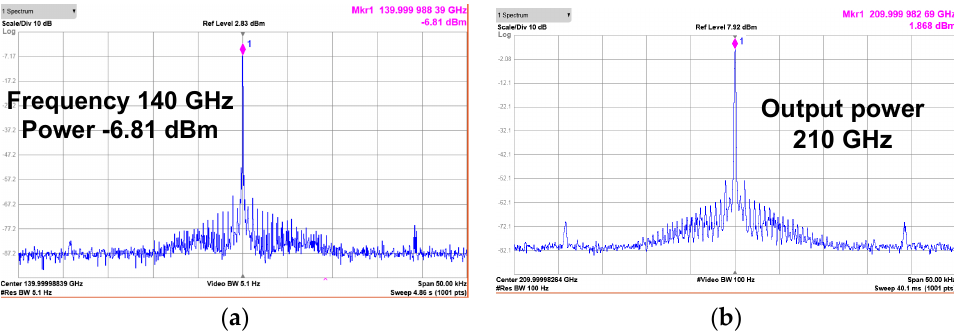
Figure 14. The output spectrum of the proposed chip ( a ) 140 GHz and ( b ) 210 GHz.